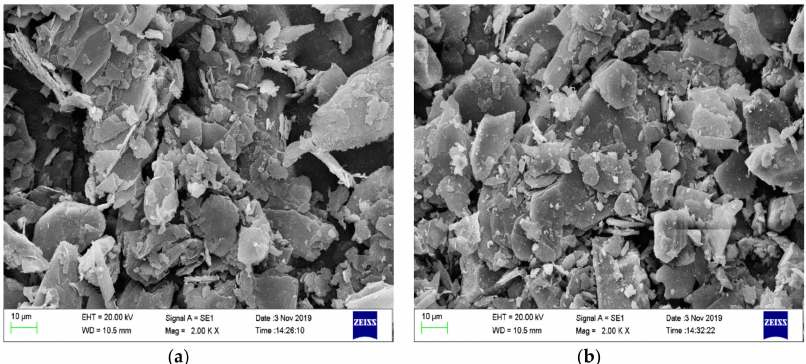
Figure 6. SEM photographs of PCM2 and PCM4. ( a ) Expanded graphite (EG), ( b ) EG + magnesium hydroxide (MH) + aluminum hydroxide